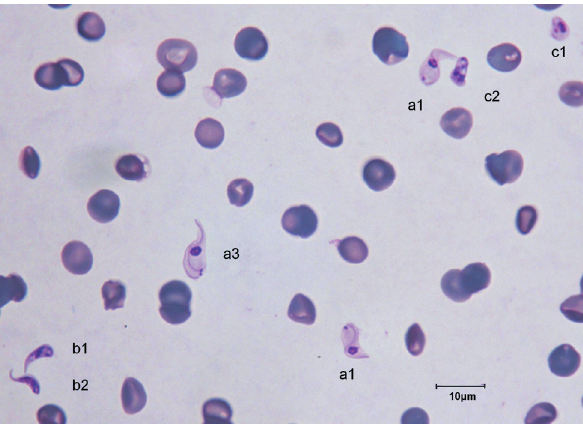
Fig. 4. – T. (Nannomonas) isomorph (b1 & b2), sphaeromorph (c1 & c2) and hyperpachymorph (a1 & a3), the central one (a3) being in division (two kinetoplasts and flagella visible). Photo by Bruno Polack.